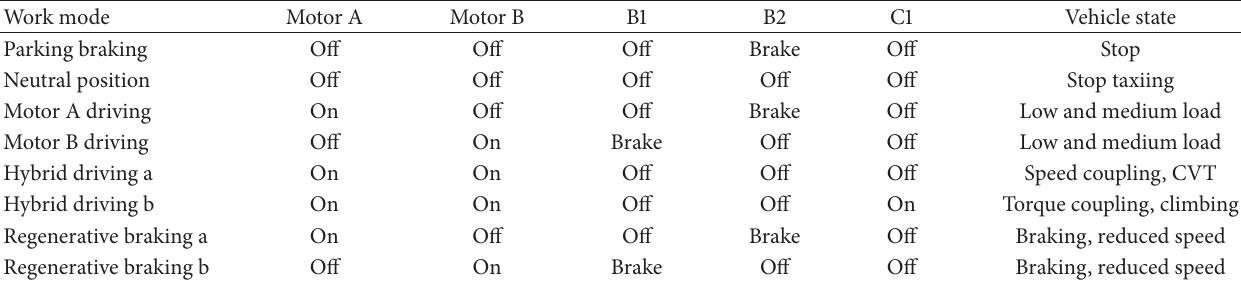
Table 1: Work mode